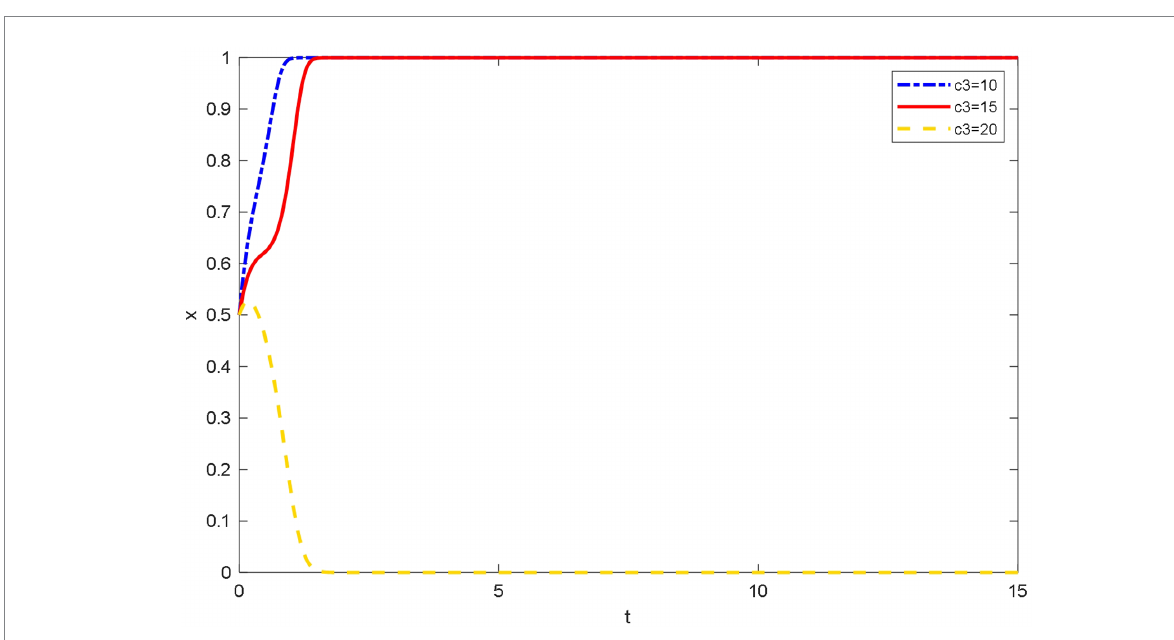
FIGURE 7 Evolutionary trajectory of doctors’ strategy selection under different reputation